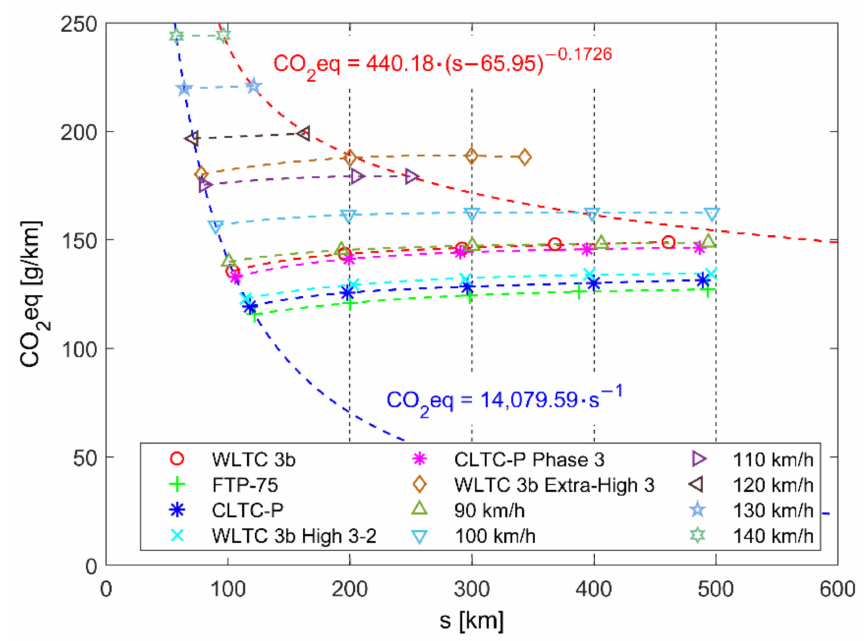
Figure A10. Combined CO 2 eq emission, due to EREV operation and electricity production (Poland), in various driving conditions. Note that the blue approximation line (BEV mode) and the red approximation line (maximal range) are obtained for constant speed driving results from the range of 90–140 km/h. Vehicle mass is equal to 2100 kg.